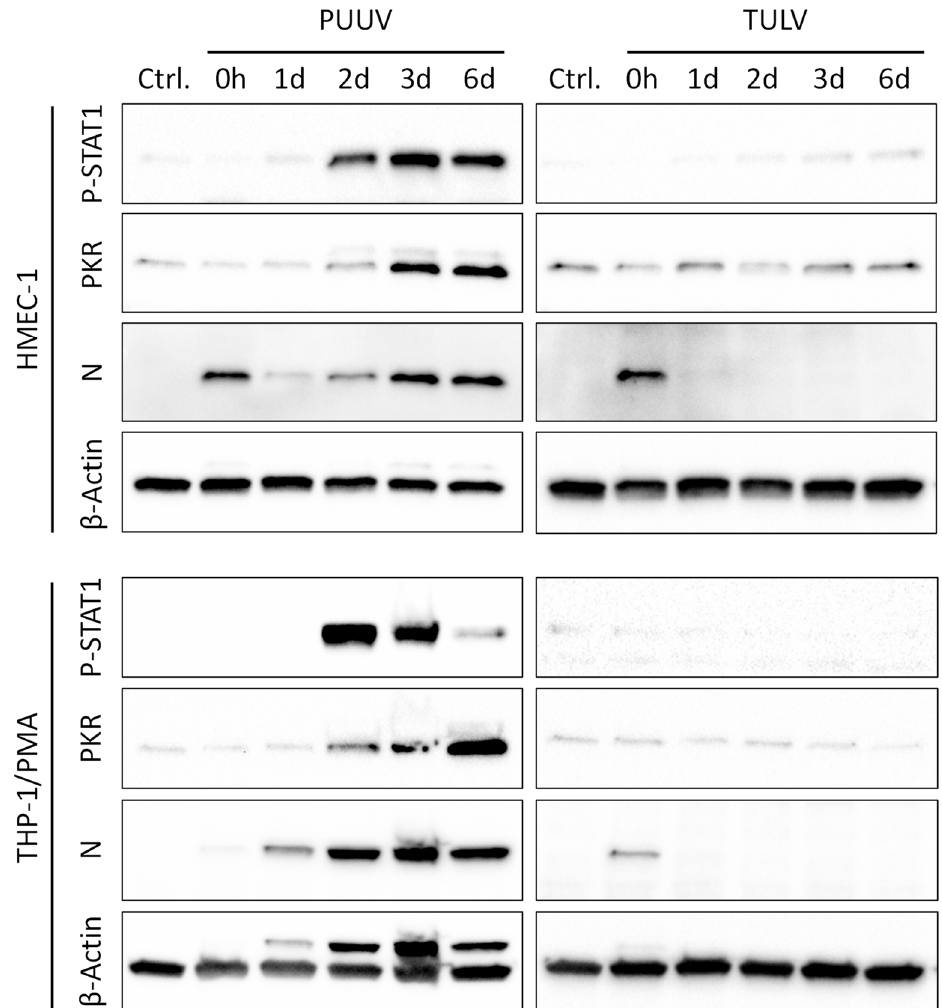
Figure 5. Interferon-stimulated protein expression in PUUV- and TULV-infected cells. The phosphorylation of STAT1 (Tyr701) and the expression of the cellular antiviral dsRNA-activated protein kinase PKR (EIF2AK2) was analyzed in lysates of PUUV- or TULV-infected HMEC-1 and THP-1 / PMA cells. Expression of the viral nucleocapsid (N) protein was detected to monitor infection and cellular β -Actin served as loading control. Cells were infected with a MoI of 0.1 and protein expression was detected at 0 h, 1 d, 2 d, 3 d, and 6 d p.i. or in non-infected